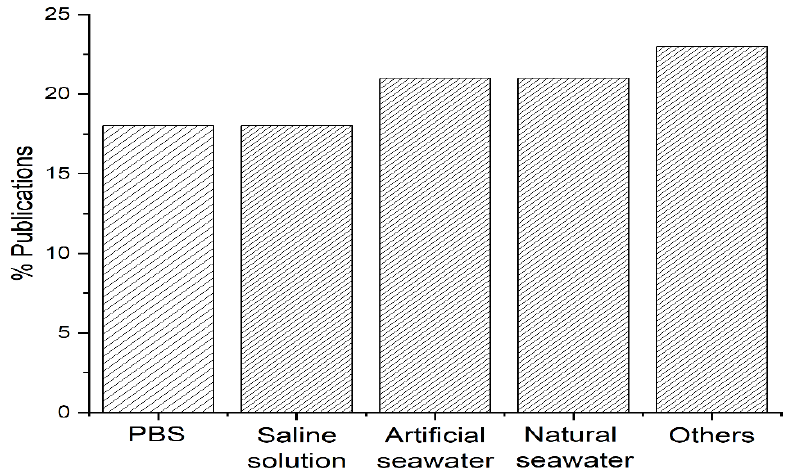
Figure 4. Types of plasma-treated saline water. PBS [22,39,40,44,51,57,60]; NaCl 0.9%